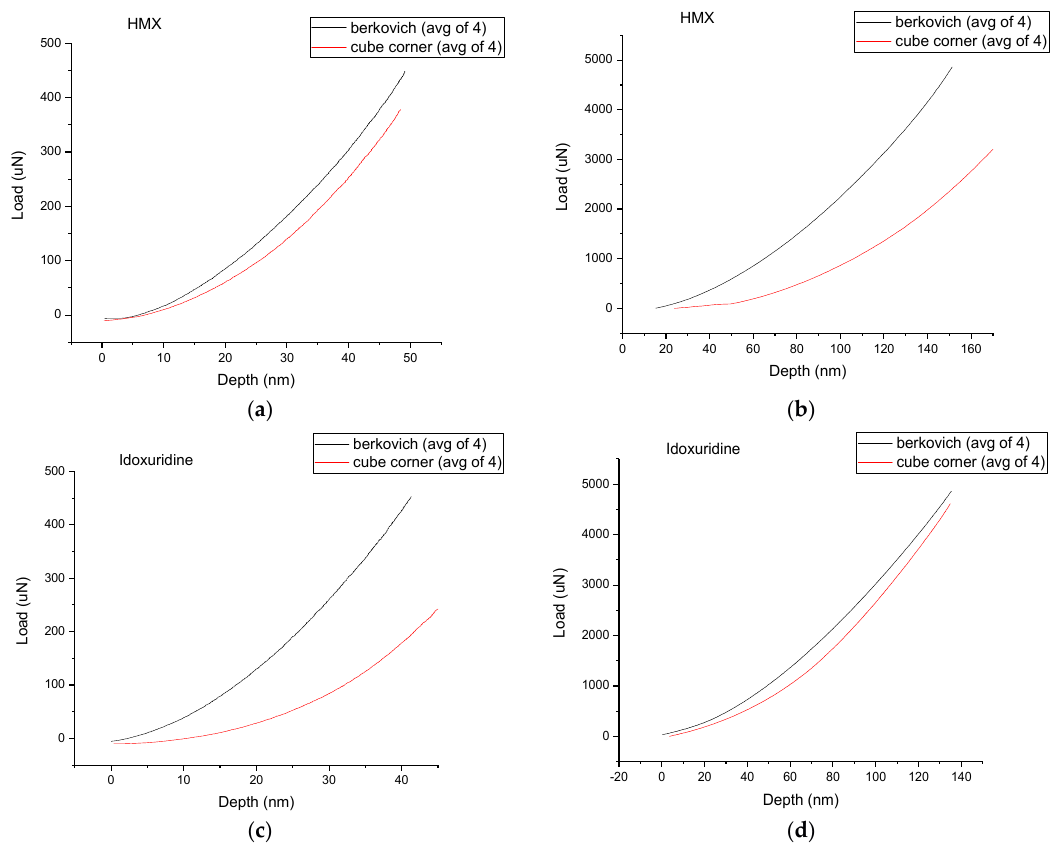
Figure 5. ( a ) HMX unloading comparison at 500 μ N. ( b ) HMX unloading comparison at 5000 μ N. ( c ) Idoxuridine unloading comparison at 500 μ N. ( d ) Idoxuridine unloading comparison at 5000 μ N.